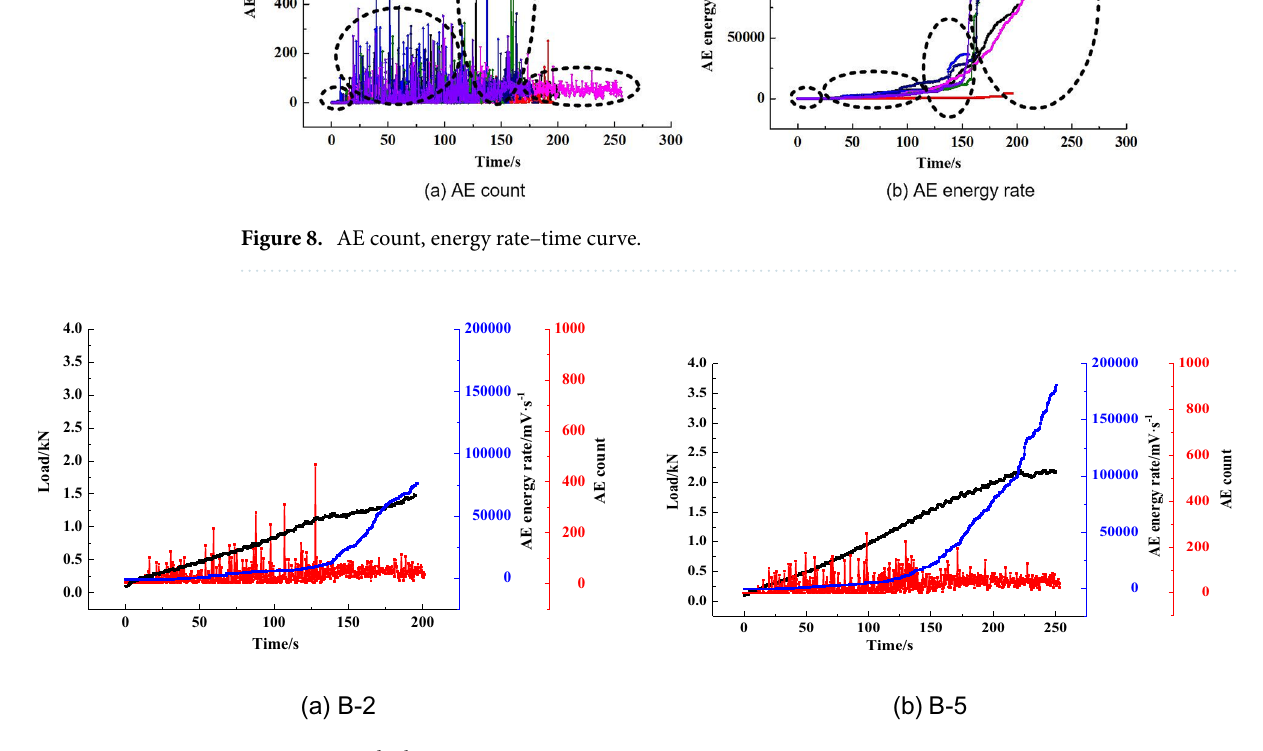
Figure 9. Gradual rise type.